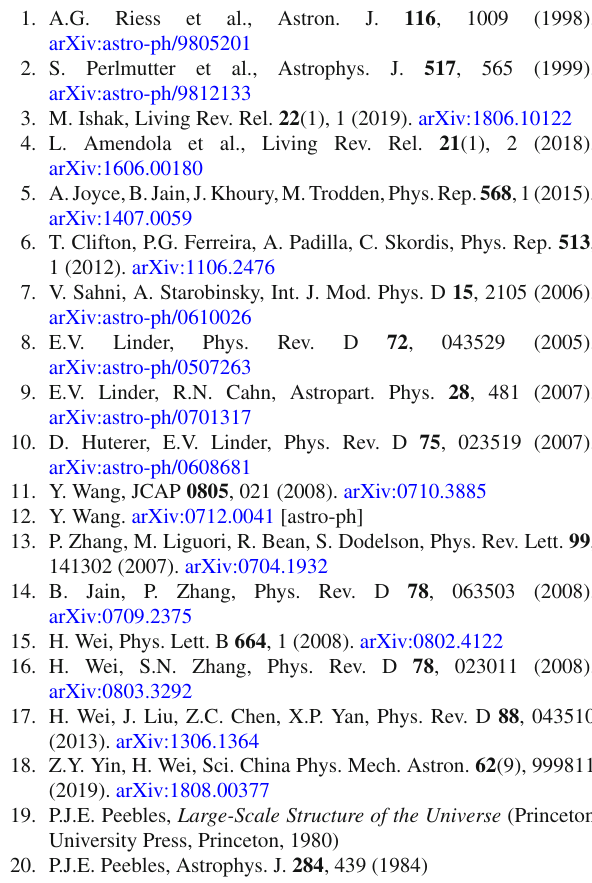
whichhas5freeparameters(n.b.Eq.(16)),andalmostdouble the number of free parameters in a 2nd order Taylor